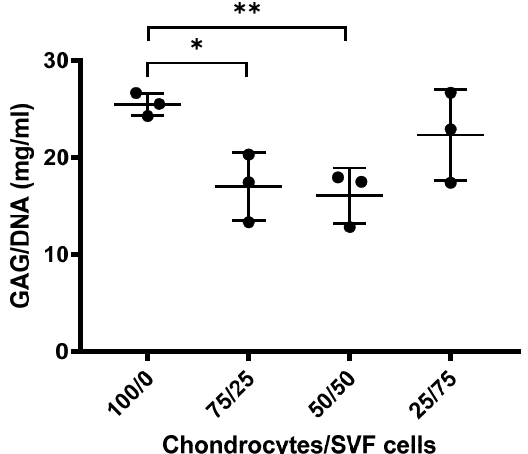
Figure 5. Sulphated glycosaminoglycan (GAG) deposition normalized for DNA content of pellets from co-cultures of chondrocytes and tSVF-derived cells after 28 days of culture at various ratios. Results are expressed as mean ± SD and analysed with an unpaired t-test. * p ≤ 0.05. ** p ≤ 0.01.